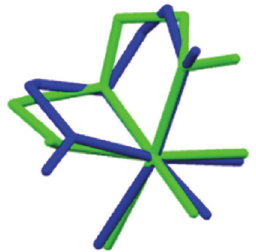
Figure 2. Two molecules of [ VCl unit of 1 are overlaid. Hydrogen atoms are omitted for clarity.